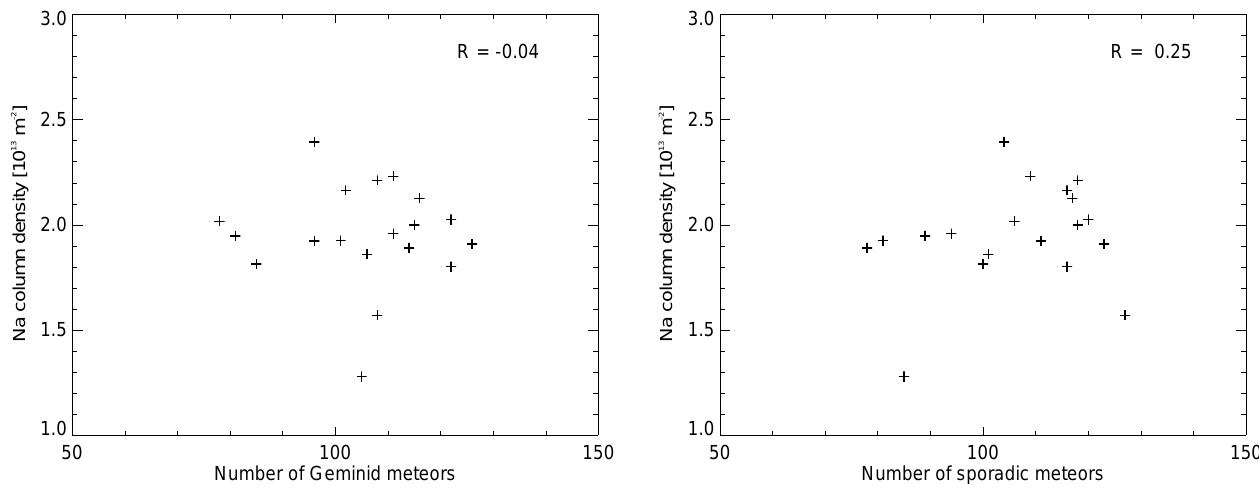
Fig. 8. Scatter plots of Na column density versus Geminids meteor number (left panel) and Na column density versus number of sporadic meteors (right panel) for 13 December 2010, 02:40 to 07:20UT. Data points are averaged over 15min. The correlation coefficients ( R ) are printed in the upper right corner of each panel. The number of Geminids meteors are separated from the sporadic meteors by their radiant of origin.